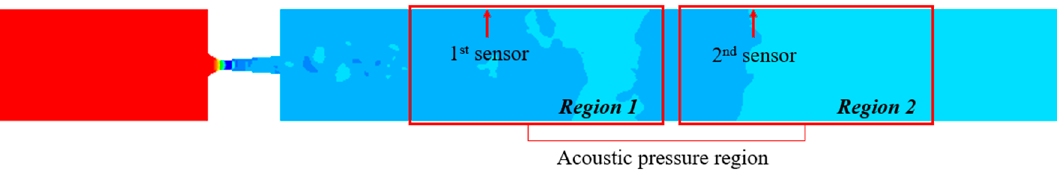
Figure 13. Acoustic pressure region. Appl. Sci. 2019 , 9 , x FOR PEER REVIEW